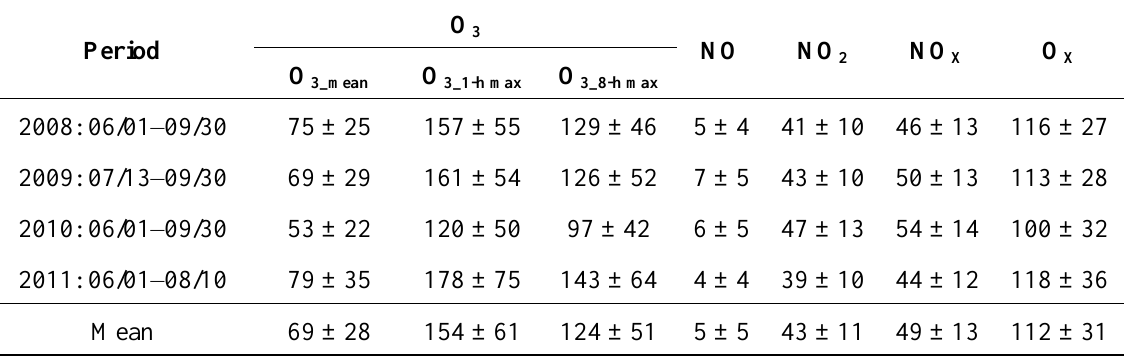
Table 1. The mean concentrations of atmospheric pollutants observed in Tangshan in summer (μg/m 3 ). O Period